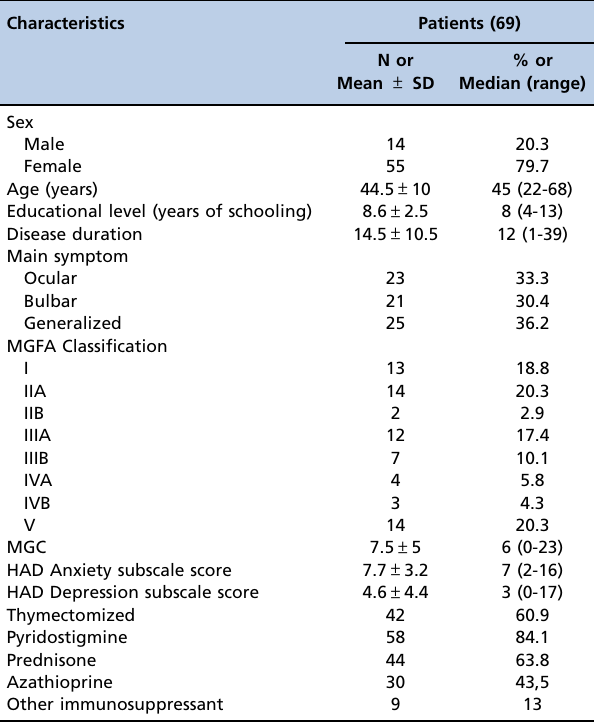
Table 1 - Characteristics of the studied myasthenia gravis patients. Characteristics Patients